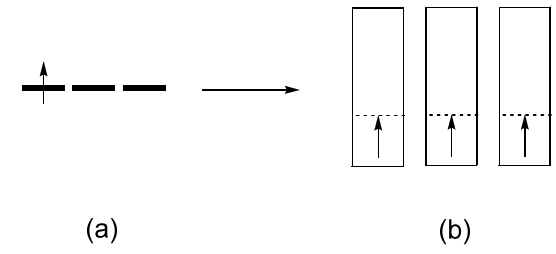
Figure 15. The formation of the t 2g -block bands of Ba 2 NaOsO 6 from the t 2g -level of the individual OsO 6 octahedra: (a) The t 2g -level of an OsO 6 octahedron. (b) The t 2g -block bands of Ba 2 NaOsO 6 . With one electron to occupy the three degenerate up-spin bands, one obtains a magnetic metallic state.